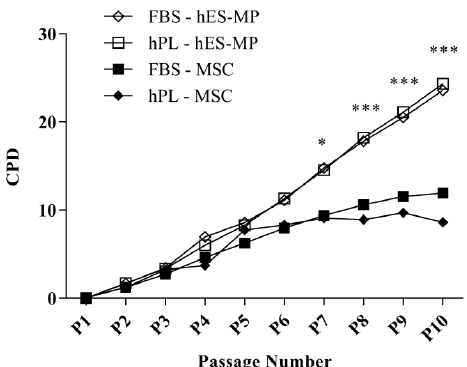
Figure 1. Long-term proliferation of human embryonic stem cell-derived mesenchymal progenitor (hES-MP) cells and mesenchymal stromal cells (MSCs). The MSCs experienced overall lower cumulative population doublings (CPDs) than the hES-MP cells. Differences in cell proliferation were not linked to the type of cell culture supplement used (human platelet lysate (hPL) or fetal bovine serum (FBS)). (* p ≤ 0.05; *** p ≤ 0.001).